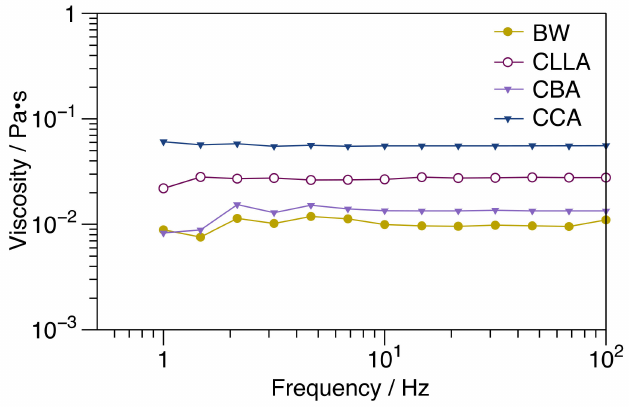
Figure 3. Shear viscosity raw waxes at a temperature of 85 ◦